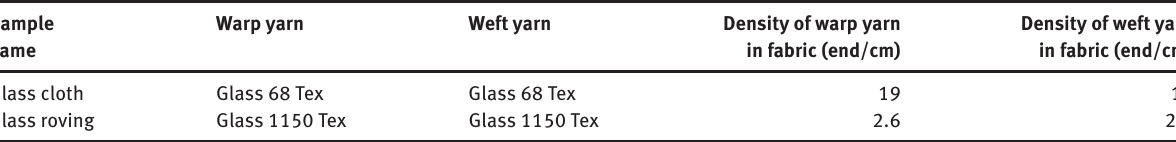
Table 1 Parameters of woven reinforcement fabrics.